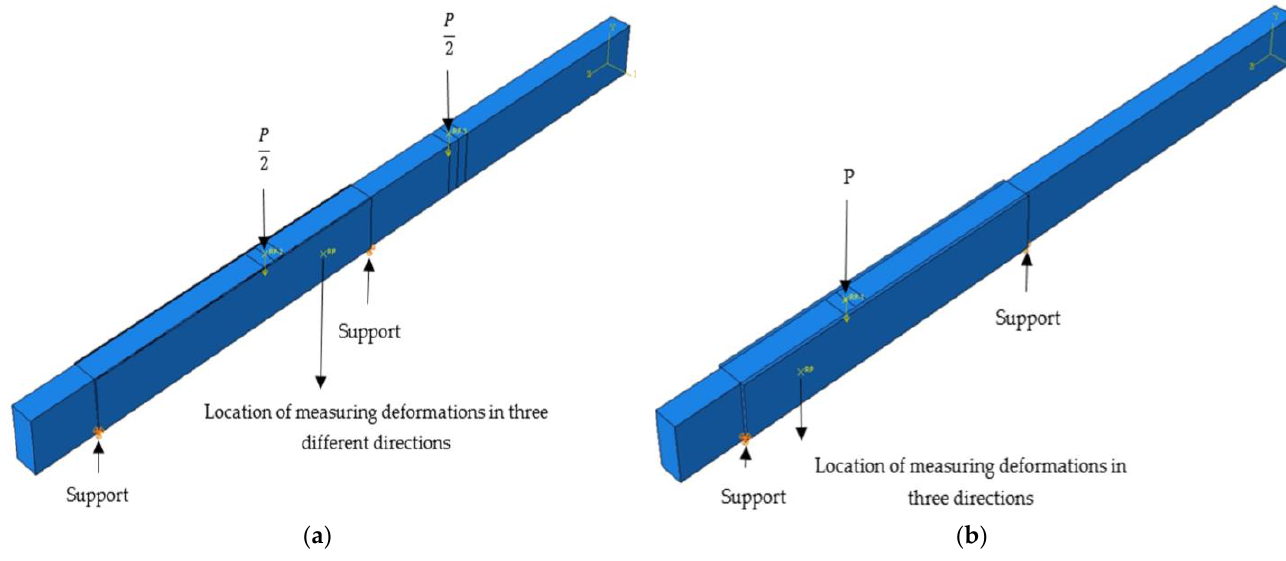
Figure 3. Loading and boundary conditions of ( a ) continuous beam, and ( b ) simply supported beam models in the FE software.